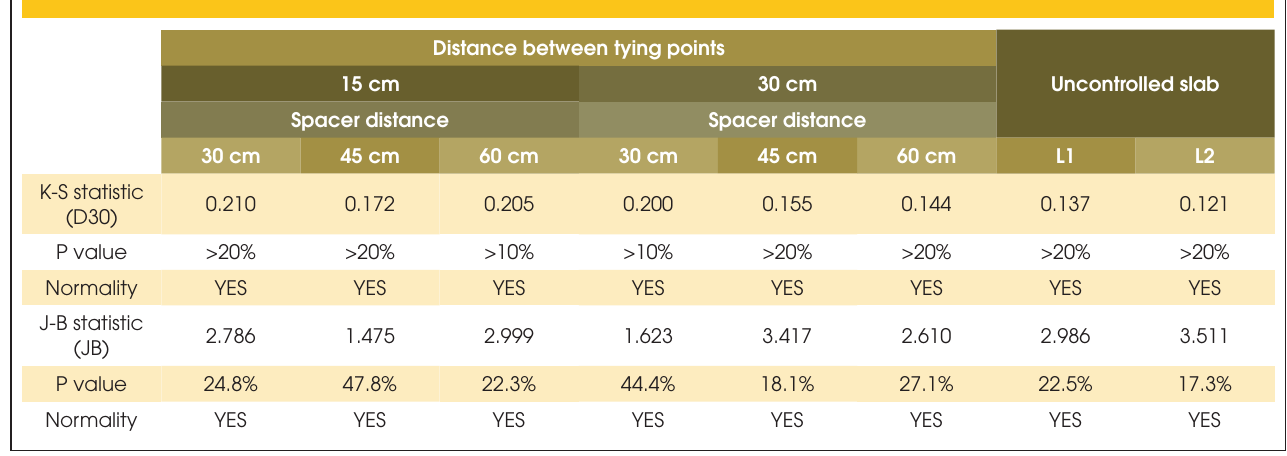
Table 2 – Normality test results for measurements